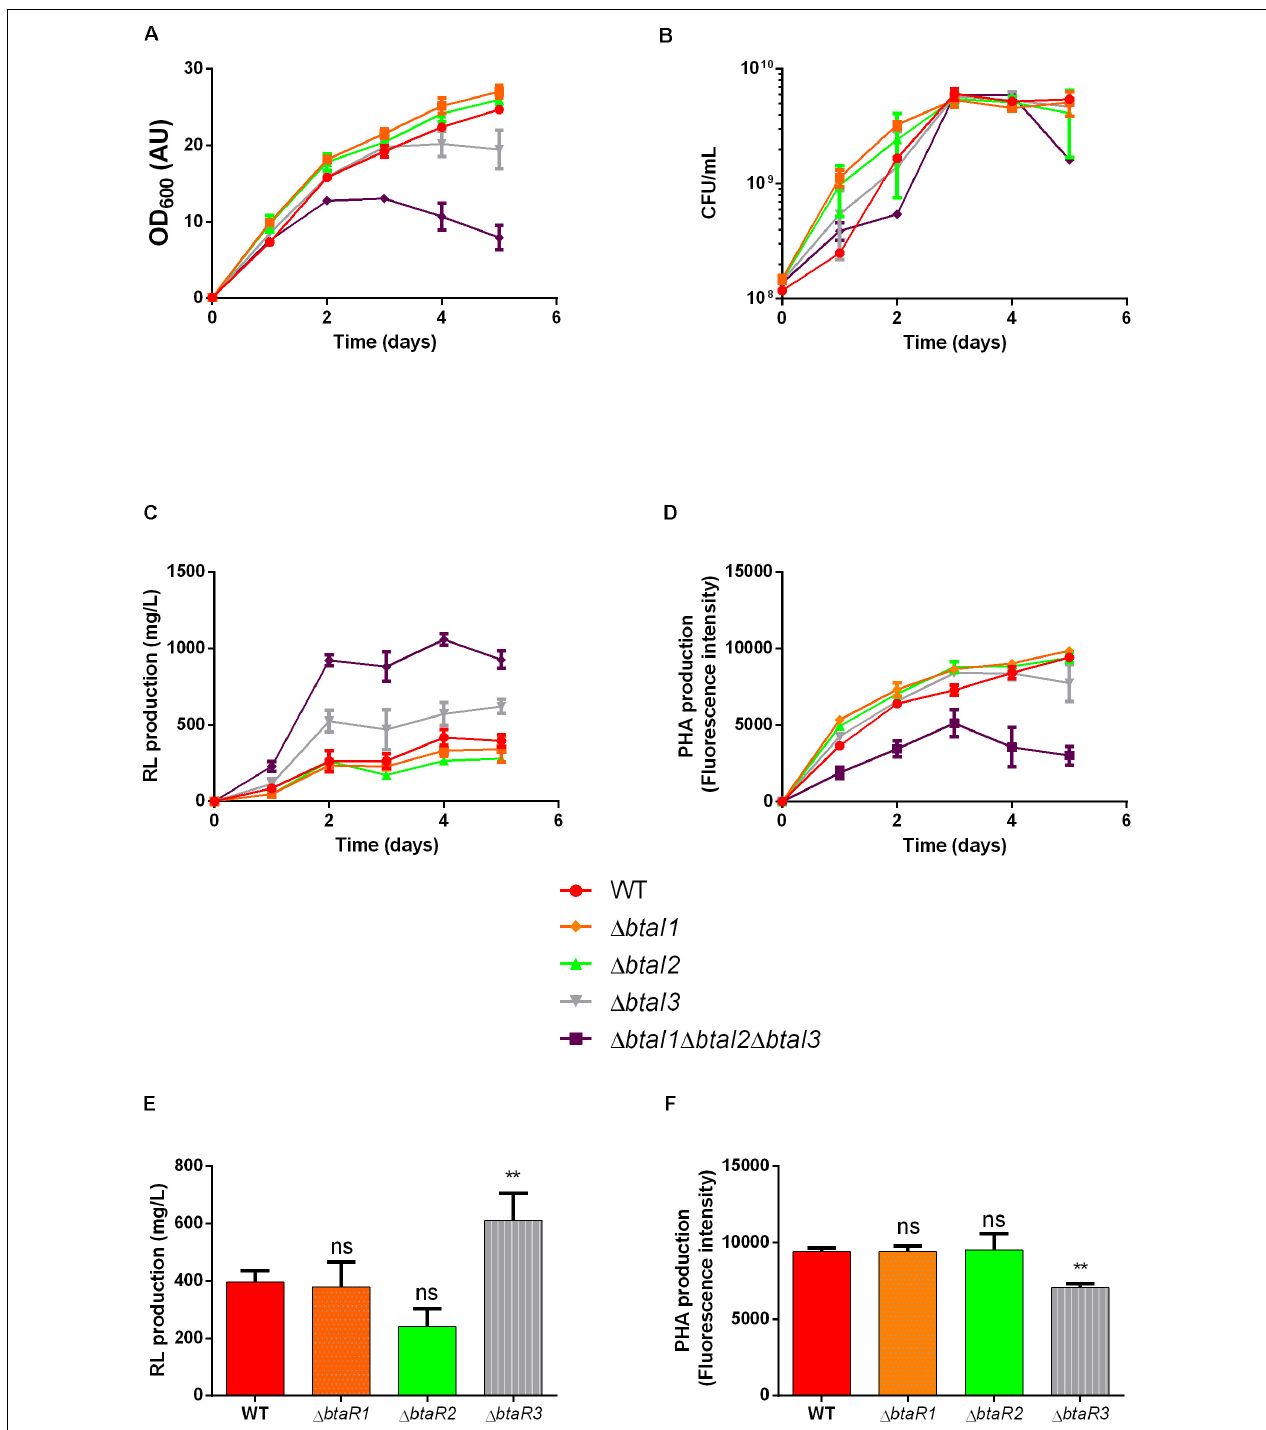
FIGURE 8 | The QS-3 quorum sensing system affects the production of both PHAs and rhamnolipids. Wild type strain E264 and isogenic quorum sensing mutants were cultured during five days at 30 ◦ C in NB medium supplemented with 2% glycerol. Growth measurements are described for (cid:49) btaI mutants in panel (A) OD 600 and (B) CFU/mL. (C) Rhamnolipid concentrations and (D) PHA levels are presented for the (cid:49) btaI mutants. (E) Rhamnolipid concentrations and (F) PHA levels are presented for the (cid:49) btaR mutants in the QS-1, QS-2 and QS-3 systems. The error bars represent standard deviation from the mean ( n = 3 independent cultures), Data analyzed using a one-way ANOVA with post hoc. Dunnett’s multiple comparisons tests ( ∗∗ p < 0.01 and ns = not significant).